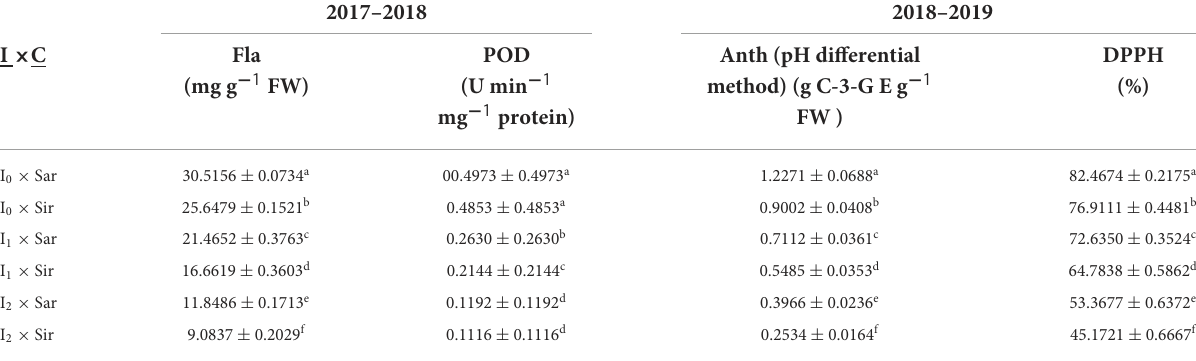
TABLE 5 Mean comparison of the dual interaction of irrigation levels and cultivar on Fla and Anth content, DPPH, and POD activity traits in 2 years of experiment (2017–2018 and